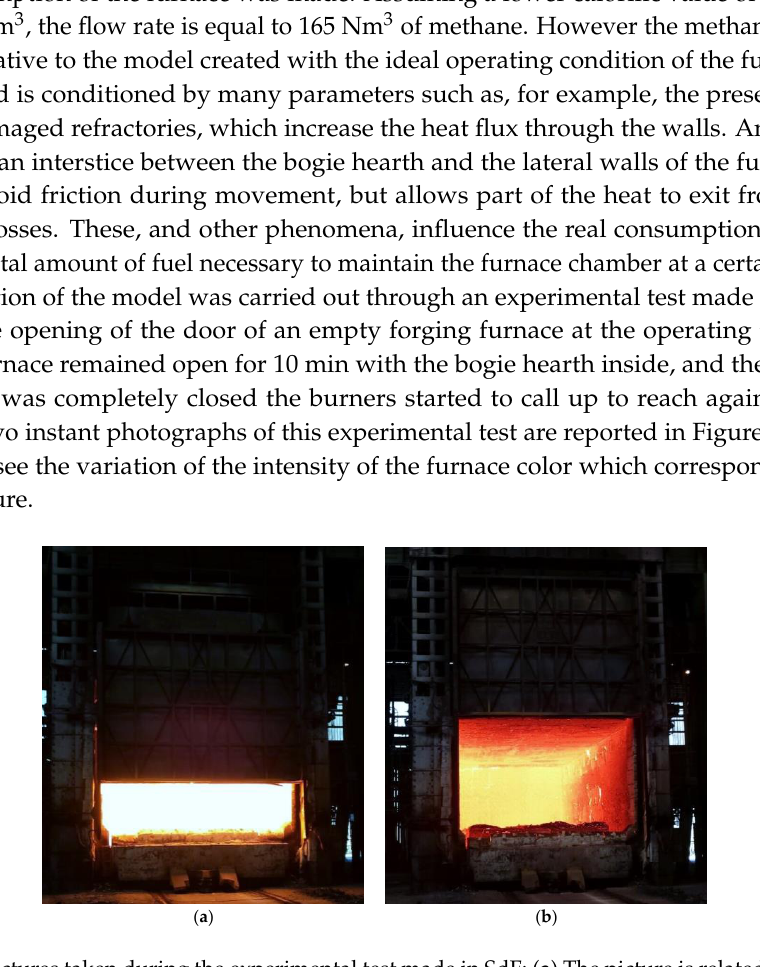
Table 2. Amount of energy lost for an opening of 600 s for radiation, convection and conduction.